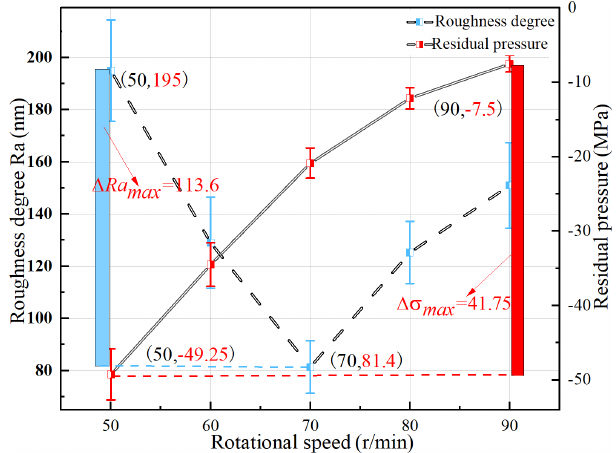
Figure 5. Relationship between rotational speed and surface rough- ness and residual